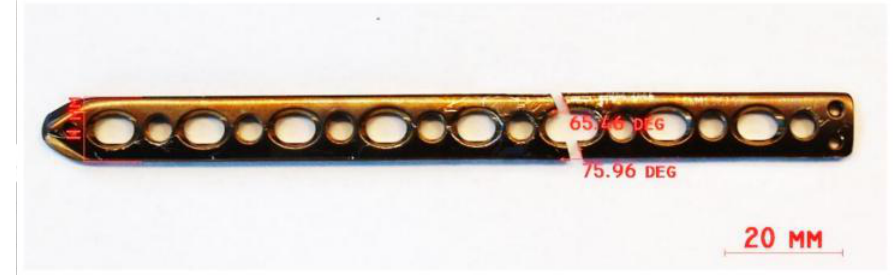
Figure 14. The retrieved LCP